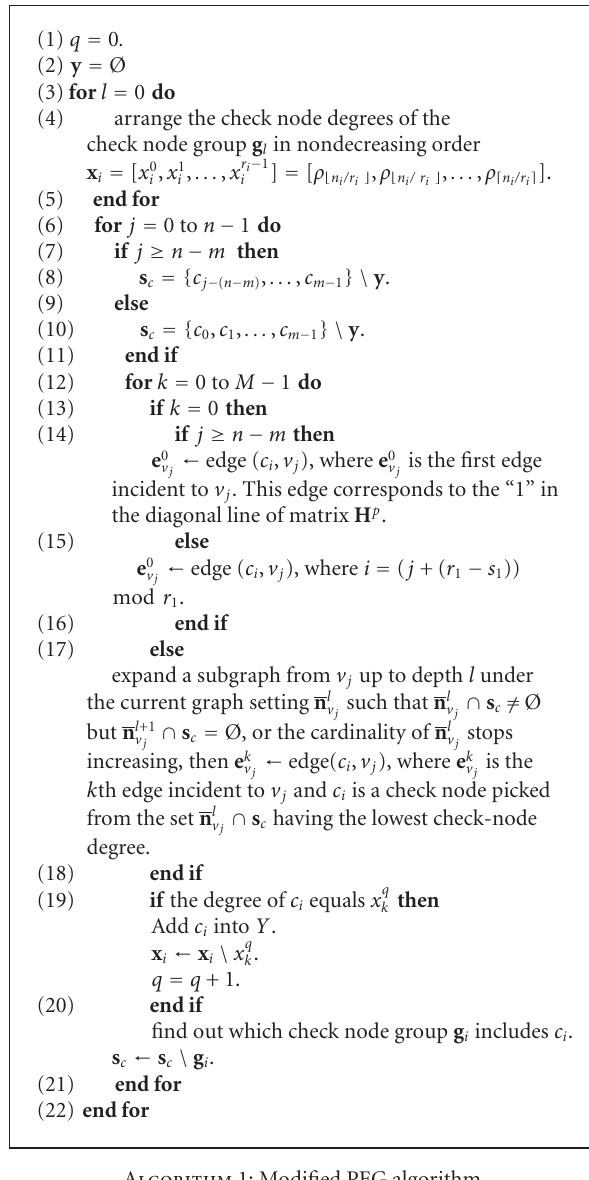
Algorithm 1: Modified PEG